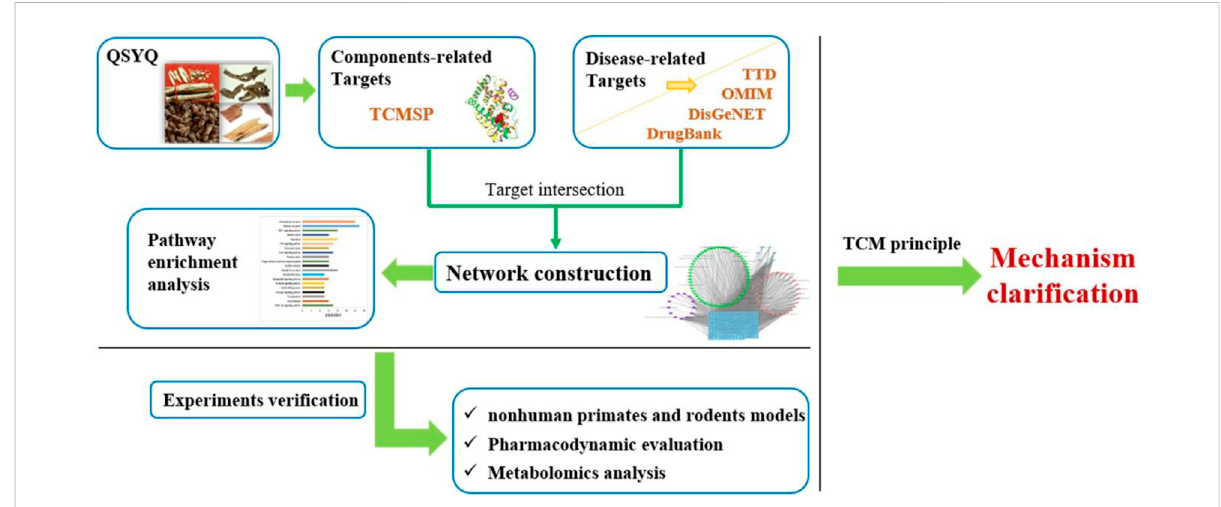
FIGURE 1 The fl owchart of the